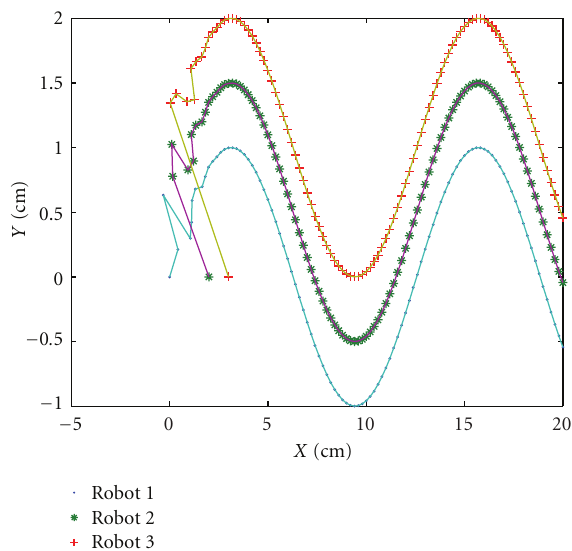
Figure 6: Evolution of the group movement with nonlinear formation with time delay ( τ = 1